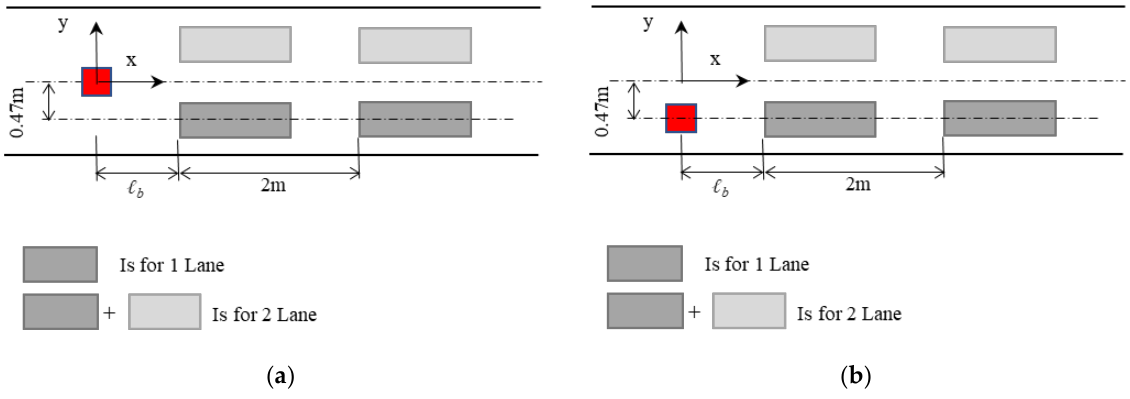
Figure 19. Top view of fire sources and obstacles: ( a ) Pattern A; ( b ) Pattern B.